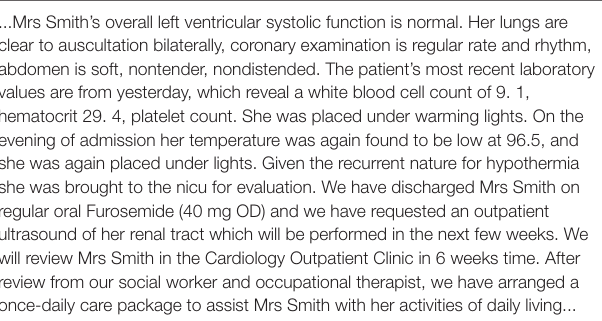
TABLE 1 | A fragment of a discharge summary (an artificial example).